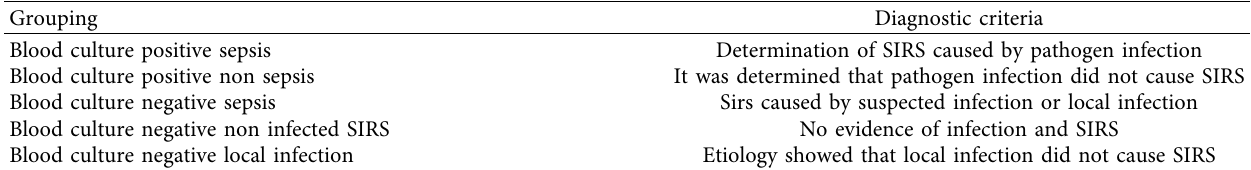
Table 1: Grouping of study subjects and diagnostic